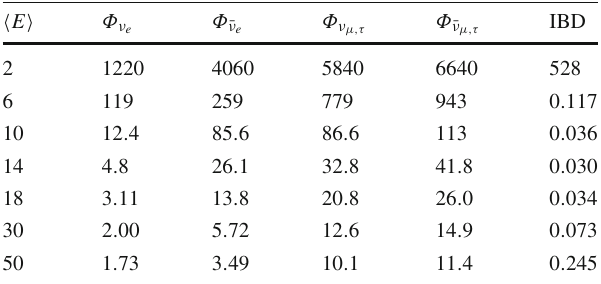
Table 3 Borexino 90% C.L. upper limits for the total FRB fluences obtained through the study of (ν, e ) scattering (2058 d) and the IBD reaction (2485 d) with supernova neutrino spectra. The mean energy (cid:10) E (cid:11) is given in MeV units, Φ ν – in 10 12 cm − 2 x , ¯ ν x